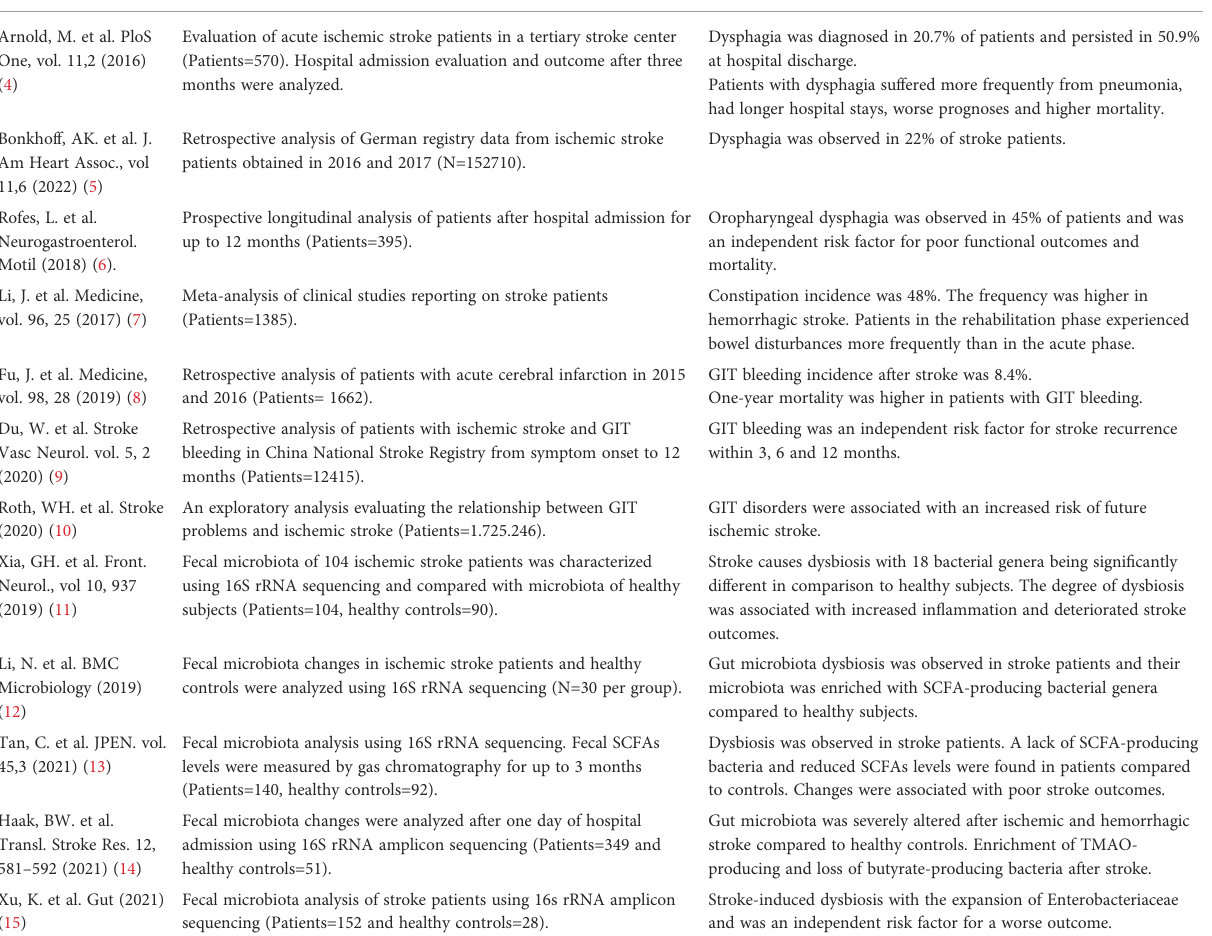
TABLE 1 Stroke induces gastrointestinal disturbances in human